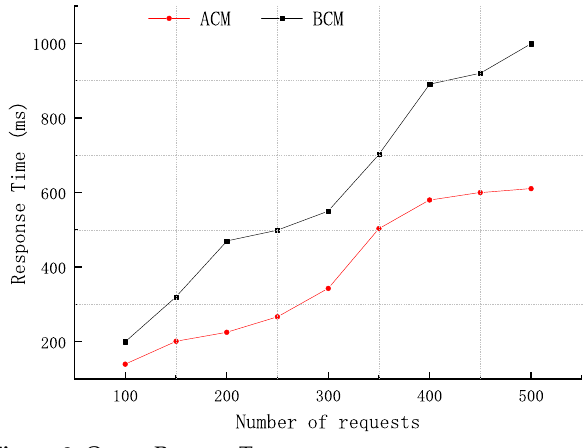
Figure 8. Query Request Test.